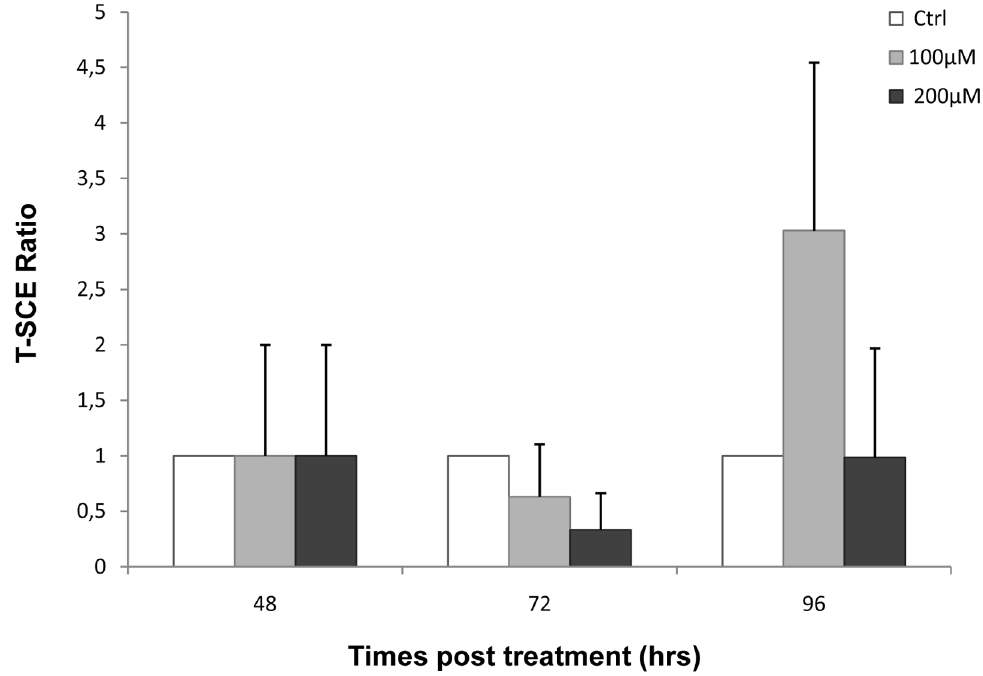
Figure 5. CO-FISH (Chromosome Orientation-FISH) analysis. The histogram represents results obtained by T-SCE (Telomere Sister Chromatid Exchanges) analysis in MRC-5 cells after hydrogen peroxide treatment. The T-SCE ratio was calculated as the ratio of the frequency from treated samples to the frequency from control samples. The results revealed no significant differences between treated and control samples. The error bars denote the standard deviation ( 6 SD). p . 0.05 by binomial probability test.